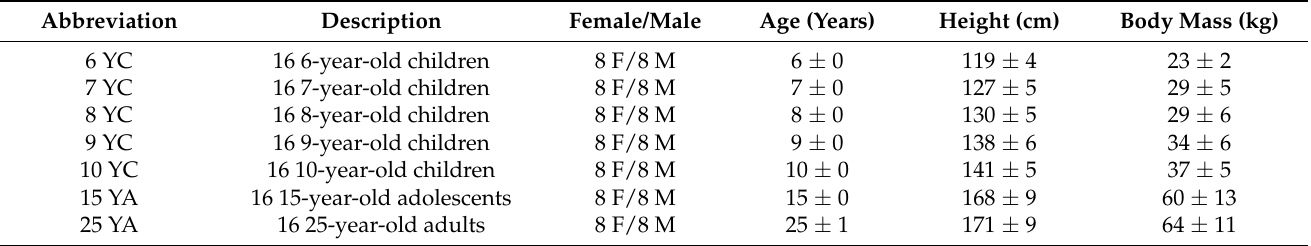
Table 2. Details of TD age groups participating in the study. Data were presented in Bisi et al.